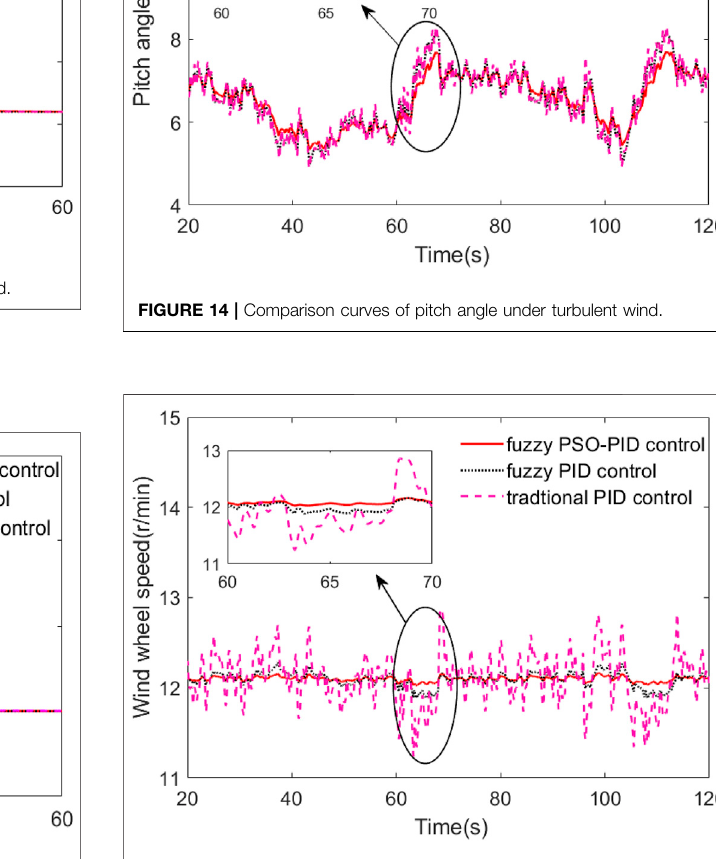
FIGURE 12 | Wind turbine output power curves under gust wind.